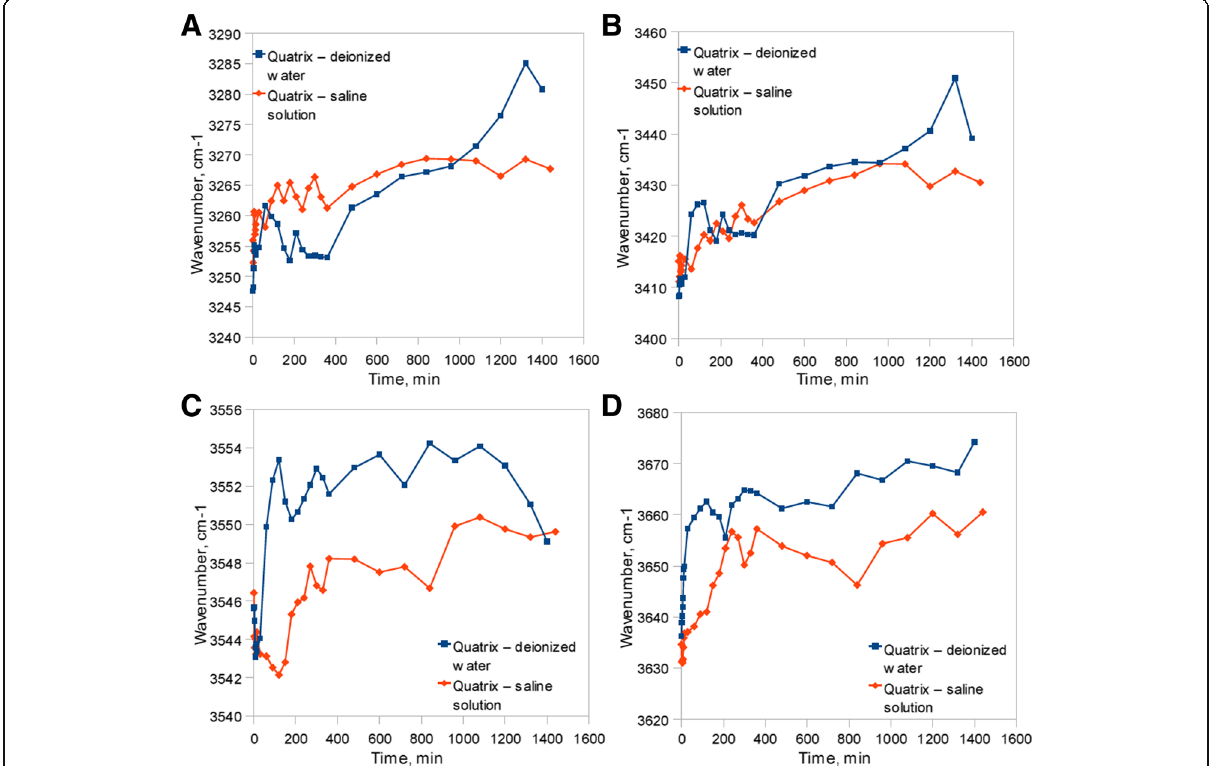
Fig. 5 Shifting of ( a ) 3250 cm − 1 , ( b ) 3400 cm − 1 , ( c ) 3545 cm − 1 , and ( d ) 3635 cm − 1 OH stretching sub-bands in